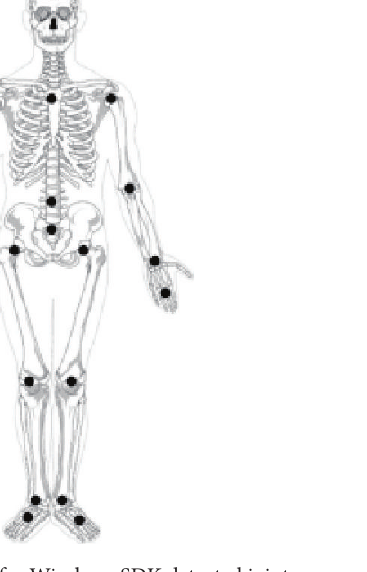
Figure 1: Kinect for Windows SDK detected joints.